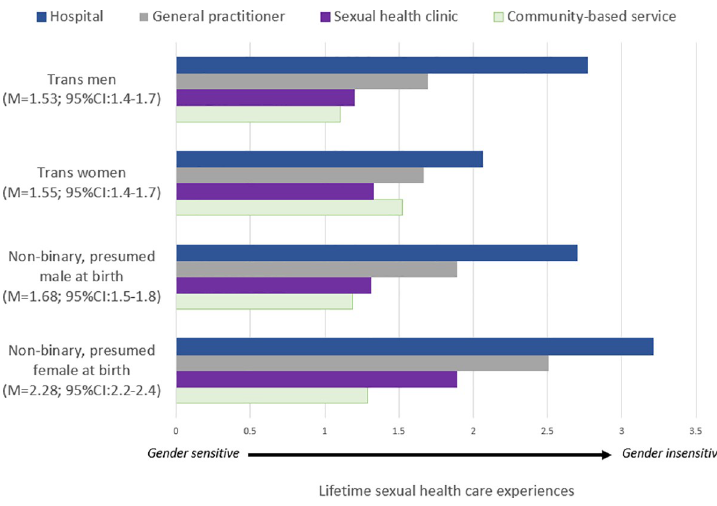
Fig 1. ‘Gender insensitivity’ scale scores (mean; 95%CI) comprising experiences of cisgenderism and transphobia when receiving sexual health care among trans and gender diverse participants (n = 1,366) a , by health setting and gender. a. Excludes participants who reported no previous sexual health care encounter (n =